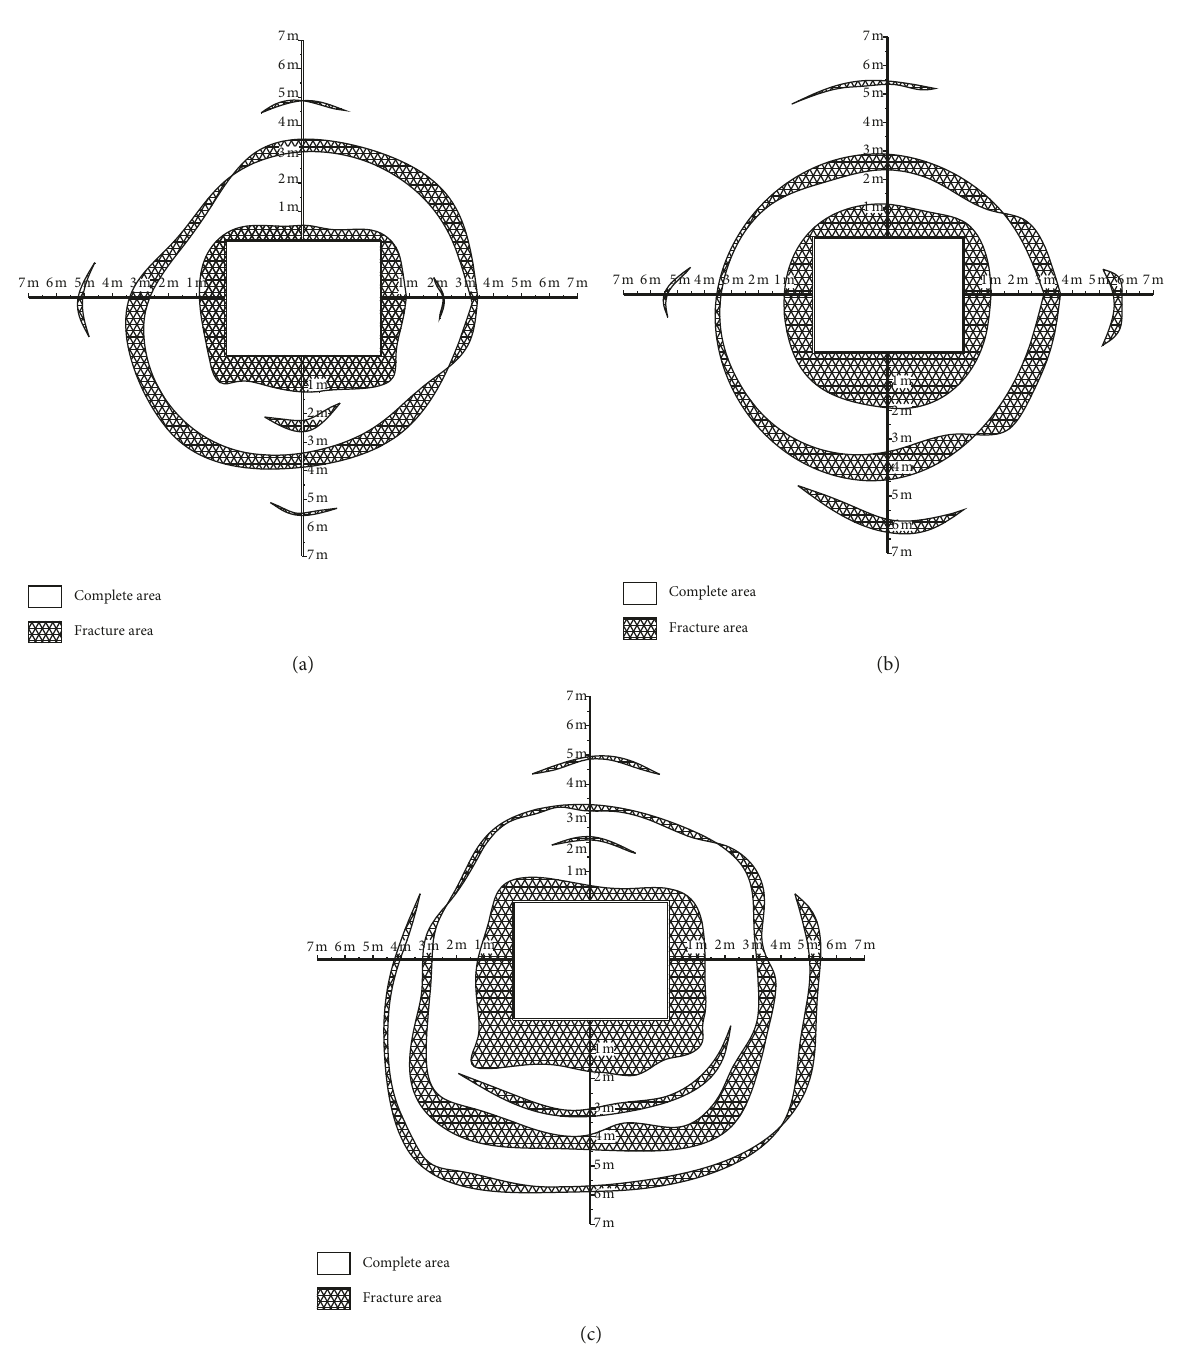
Figure 15: Fracture distribution of the roadway-surrounding rock. (a) A Section. (b) B Section. (c) C